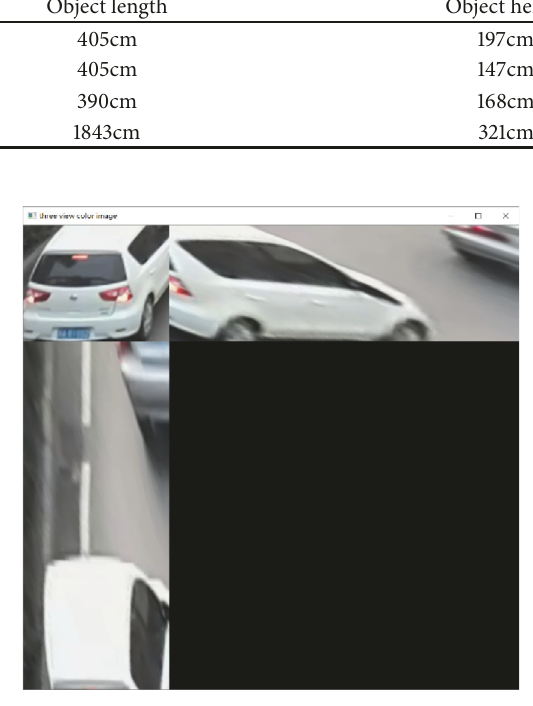
Figure 38: Three-view color image of suv.